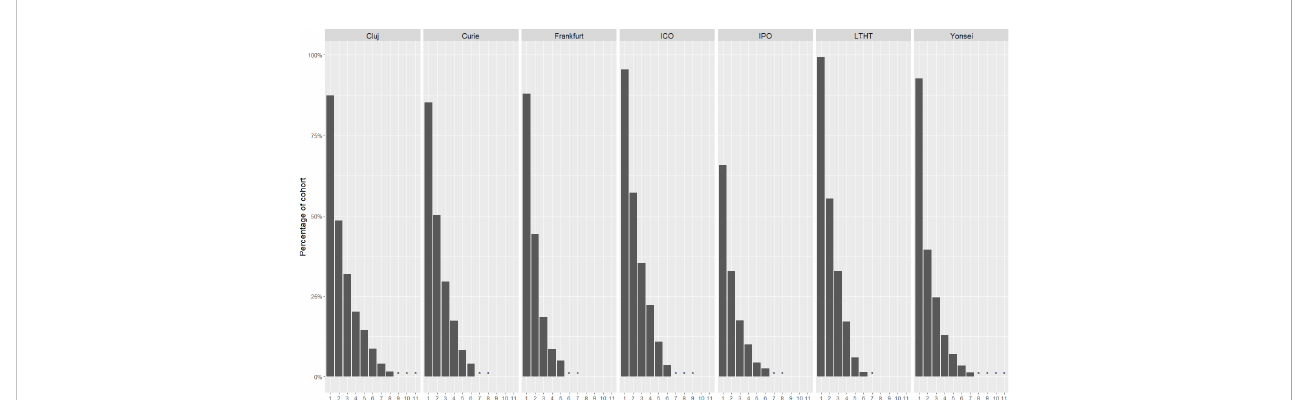
FIGURE 4 Proportion of cohort receiving systemic anti-cancer therapy (SACT) following diagnosis, including treatment attrition through successive lines of therapy (LoT), by study site. *indicates where cohort treated was <6